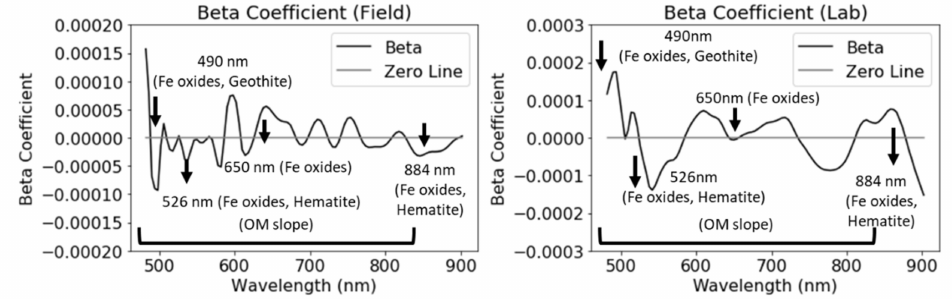
Figure 12. Beta coefficients of the PLSR models for the prediction of WIR using the samples of the clayey group with the resampled data (to the Cubert spectral